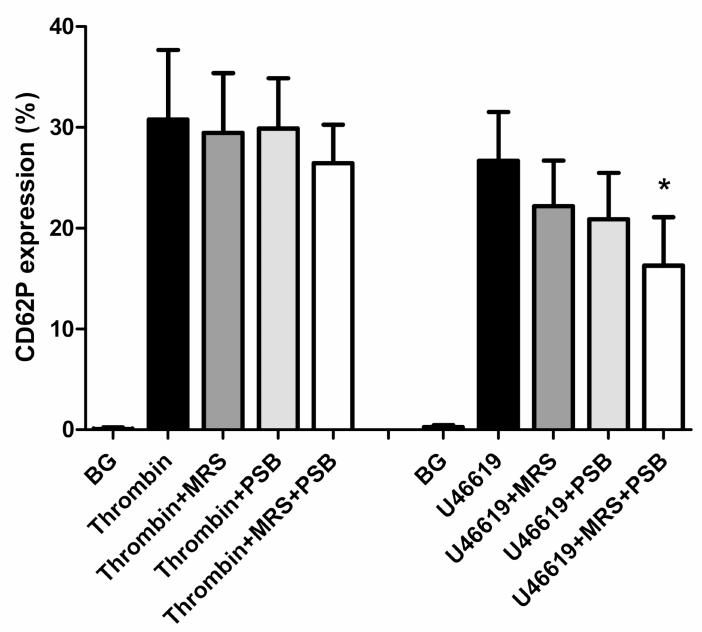
Figure 2. E ff ects of MRS2500 (MRS) and PSB0739 (PSB) both at 10 µ mol · L − 1 individually and in combination on the magnitude of expression of CD62P on platelets activated with thrombin (0.6 NIH units · mL − 1 ) or with U46619 (1 µ mol · L − 1 ). The results are expressed as the mean% activated platelets ± SDs. * p < 0.004 for comparison with the drug-free control system. BG = unstimulated platelets ( n = 5 individual donors with 7–8 experiments in the